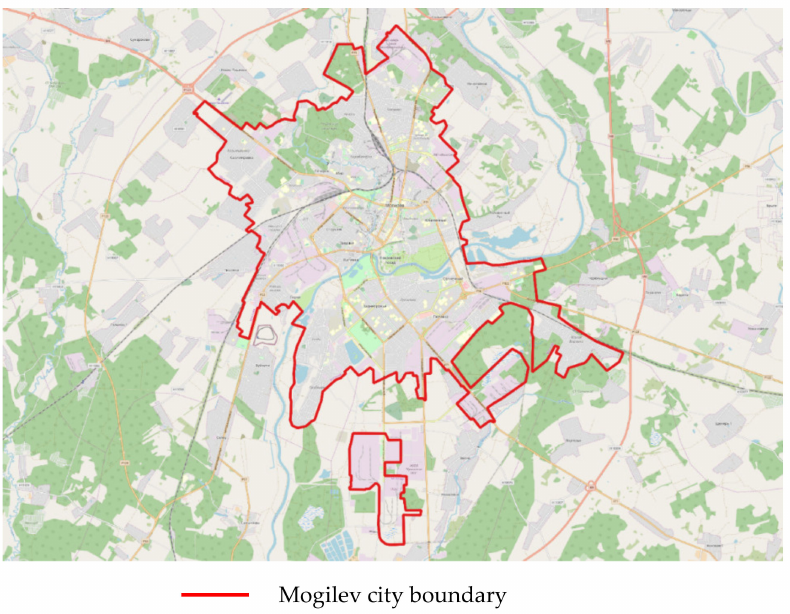
Figure A6. The Mogilev district map tile